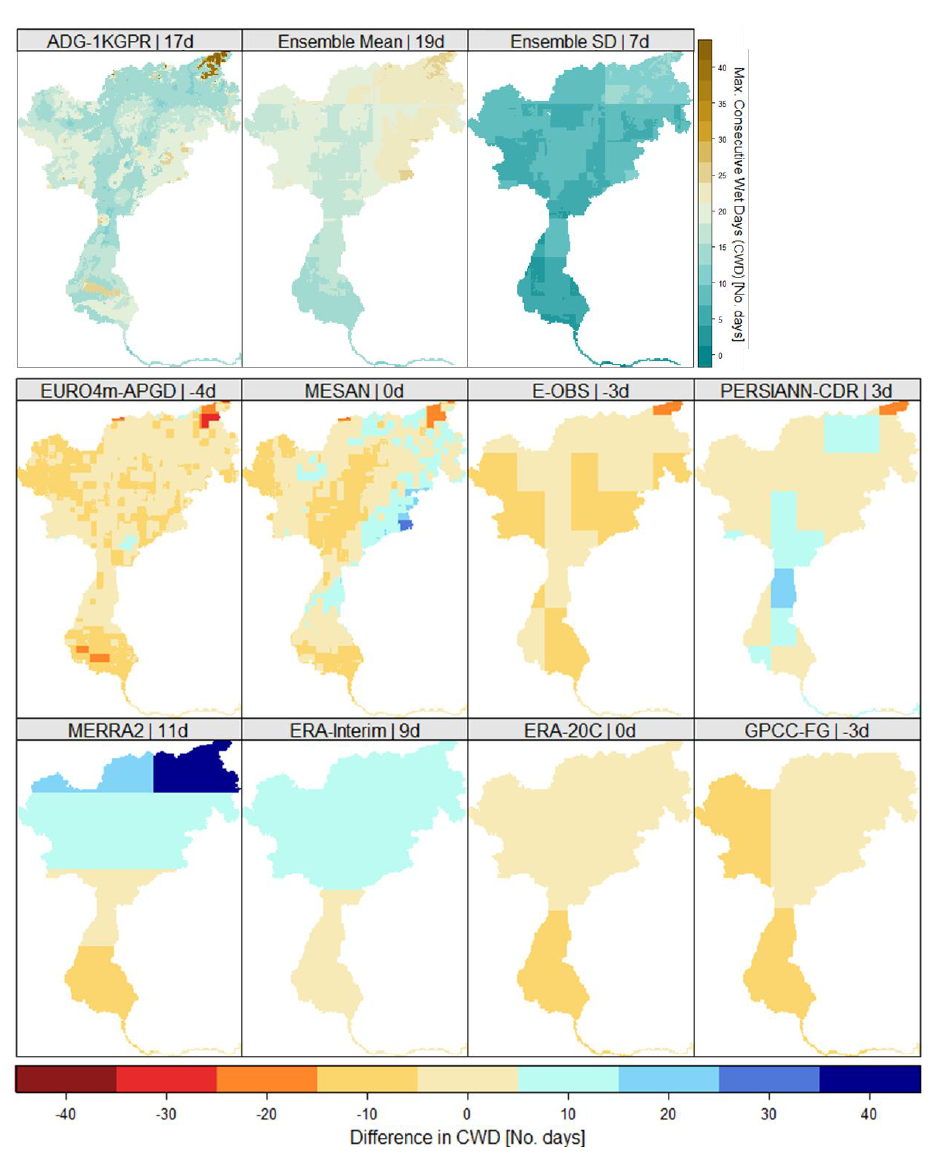
Figure 9. Same as Figure 8 but for consecutive wet days (CWD).